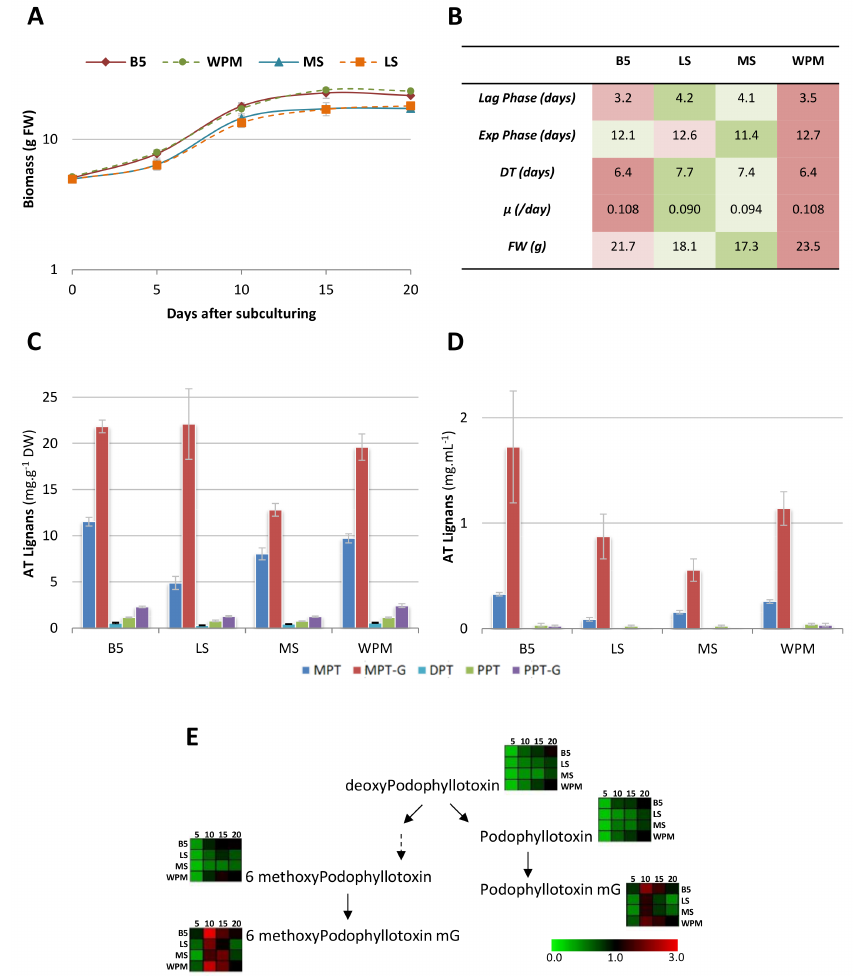
Figure 3. Impact of basal medium composition on the growth characteristics and ATL accumulation of the HRLF15.2 line. ( A ) Growth kinetics of Linum flavum HR (in g of fresh weight) cultivated in flasks containing 100 mL of B5, WPM, MS and LS culture media; ( B ) Growth characteristics of the HRLF15.2 line in the B5, WPM, MS and LS culture media; ( C ) Intracellular accumulation of the main ATL and their glucosylated forms in HRLF15.2 line growing in the B5, WPM, MS and LS culture media; ( D ) Extracellular accumulation of the main ATL and their glucosylated forms in HRLF15.2 line growing in the B5, WPM, MS and LS culture media; ( E ) Relative intracellular accumulation kinetic of the main ATL and their glucosylated forms in HRLF15.2 line growing in the B5, WPM, MS and LS culture media. Detailed ATL accumulation kinetics are presented in Figure S1. Each point is the mean and standard deviation of the three independent